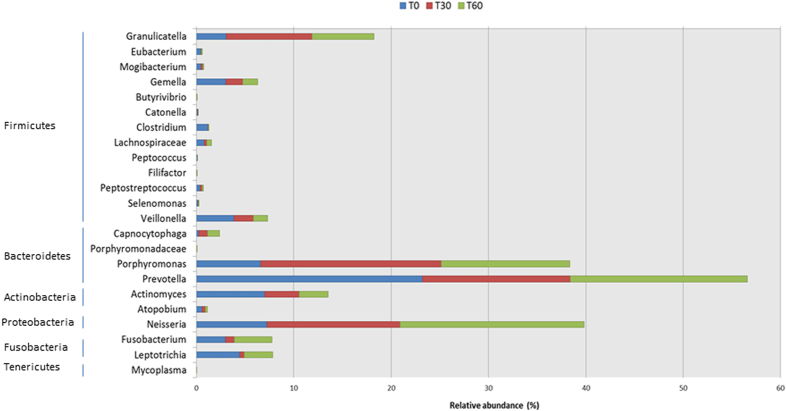
Relative abundance (%) of genera.Relative proportions (%) of predominant bacteria, which showed significant (P < 0.050) differences between the salivary samples of Saharawi celiac children under African-style gluten-free diet (T0), and after 30 (T30) and 60 (T60) days of intervention with Italian-style gluten-free diet.